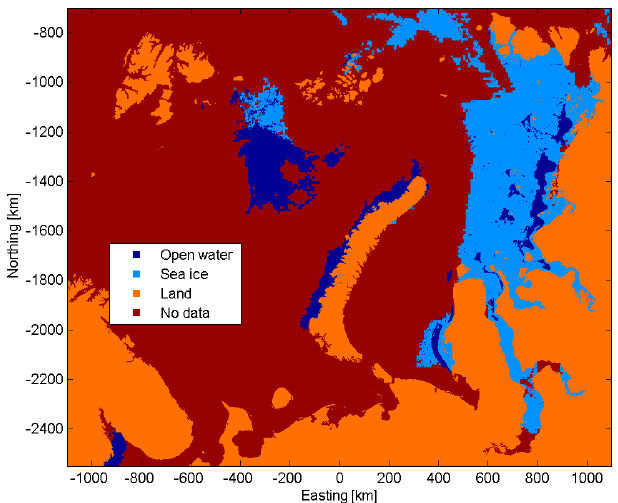
Figure 14. Daily open water–sea ice classification chart on 12 May 2016 calculated from Terra and Aqua MODIS swath data charts. A METNO ice chart for the same date is shown in Figure 5 and a MODIS RGB-image from bands 3-6-7 in Figure 15.